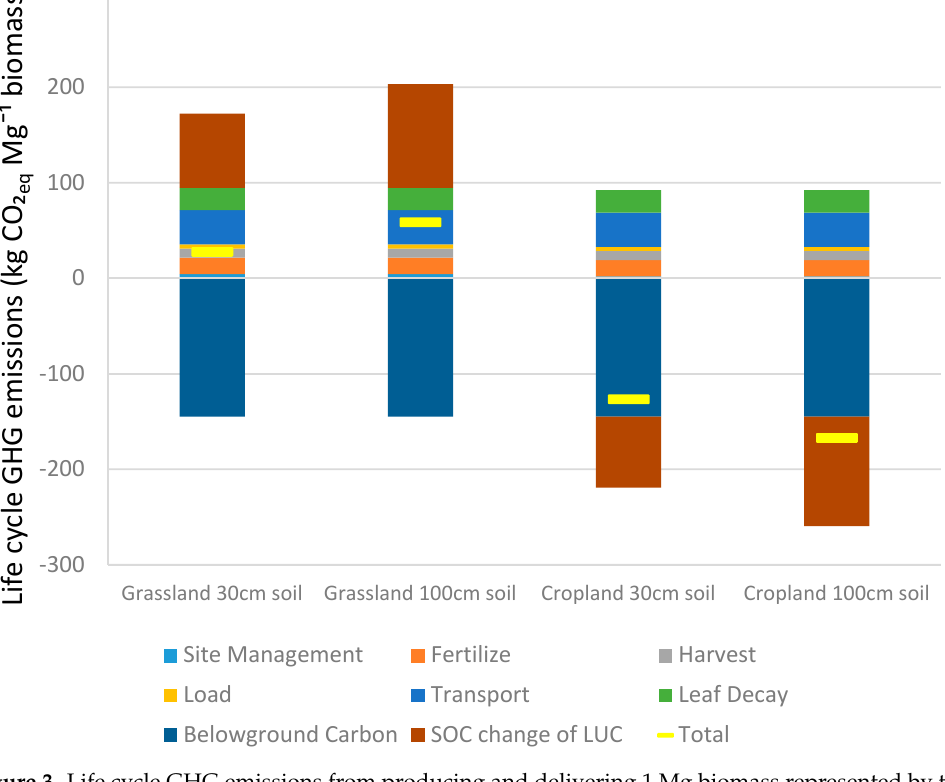
Figure 3. Life cycle GHG emissions from producing and delivering 1 Mg biomass represented by the yellow bar in four scenarios including 30 and 100 cm soil depths with grassland and cropland land cover converted to willow. The legend is read from left to right starting with site management as the first positive category, followed by fertilizer through to leaf decay.